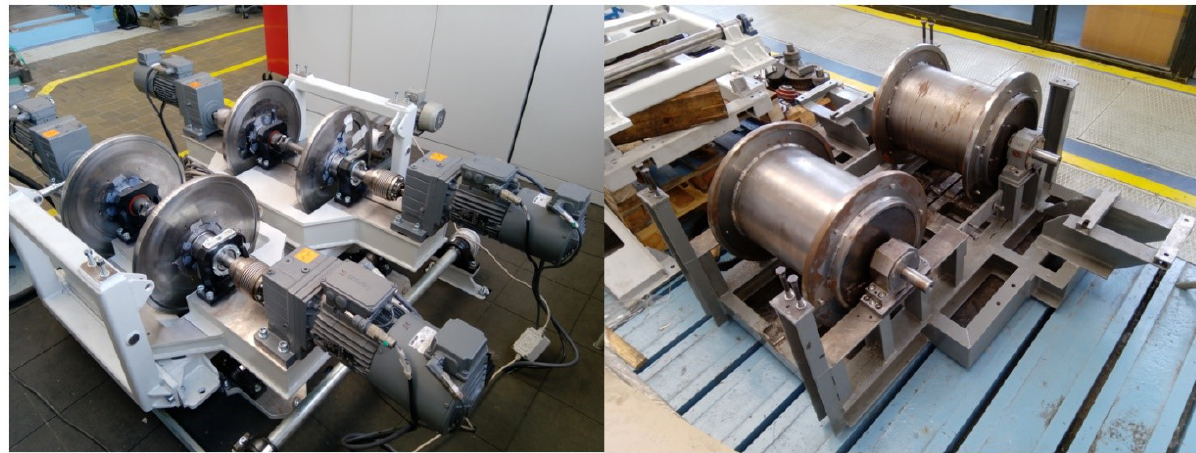
Figure 1. Roller rigs – Faculty of Mechanical Engineering at CTU in Prague.